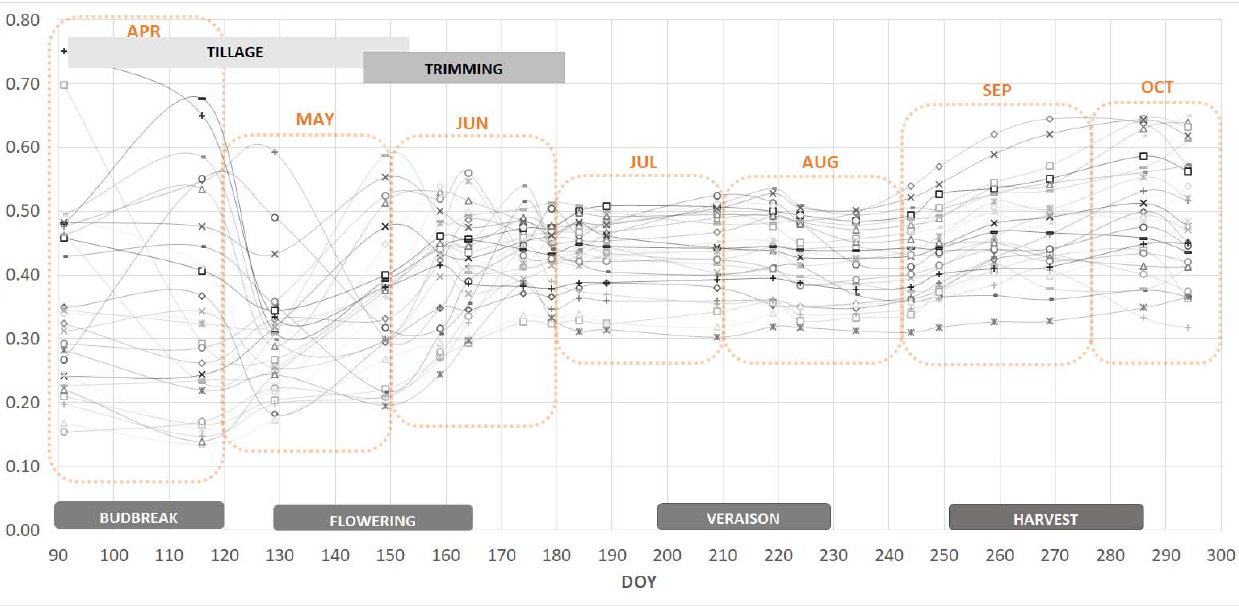
Figure 7. Temporal dynamic ranges of NDVI for the 27 vine parcels represented by lines with different symbols, time periods of phenological stages (budbreak, flowering, veraison, harvest) and time periods of management applications (tillage, trimming).